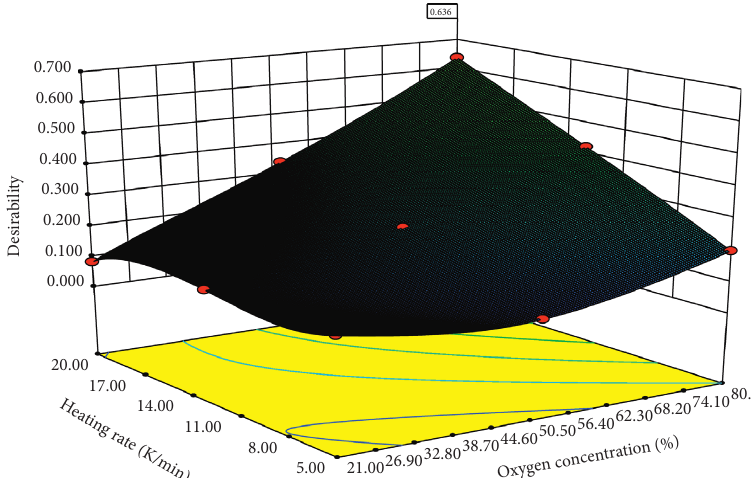
Figure 7: The optimized contour map of oxygen concentration and heating rate.